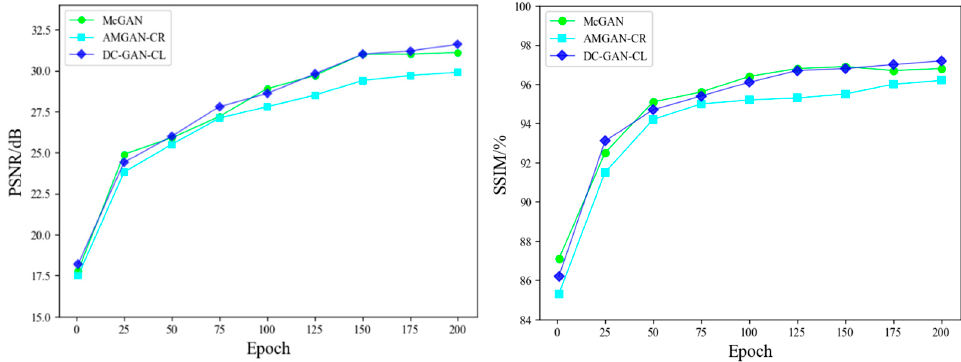
Figure 8. Trends in the PSNR and SSIM values of McGAN, AMGAN-CR, and DC-GAN-CL on the RICE1 test set throughout training.